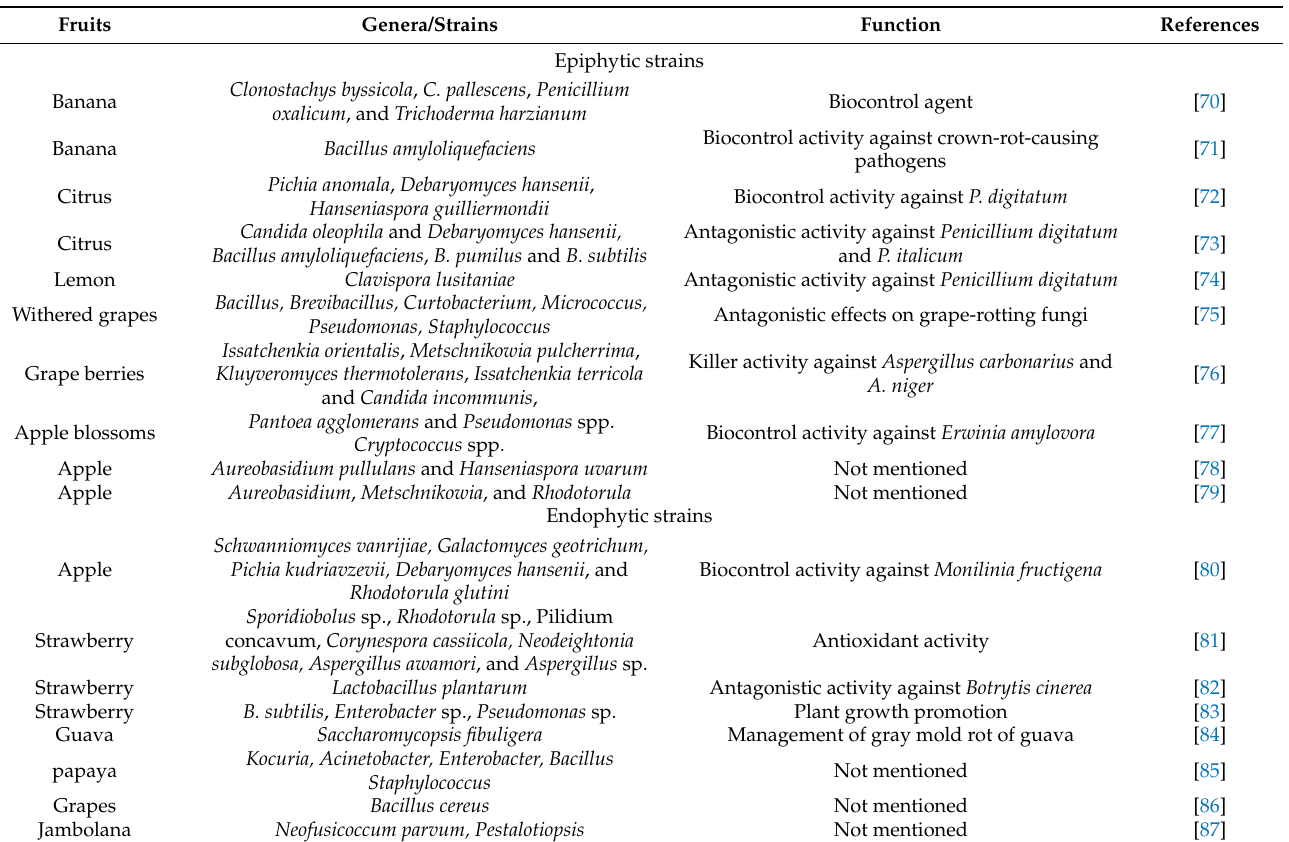
Table 1. Epiphytic and endophytic microbial strains of fruits and their potential application in postharvest pathogen management and other